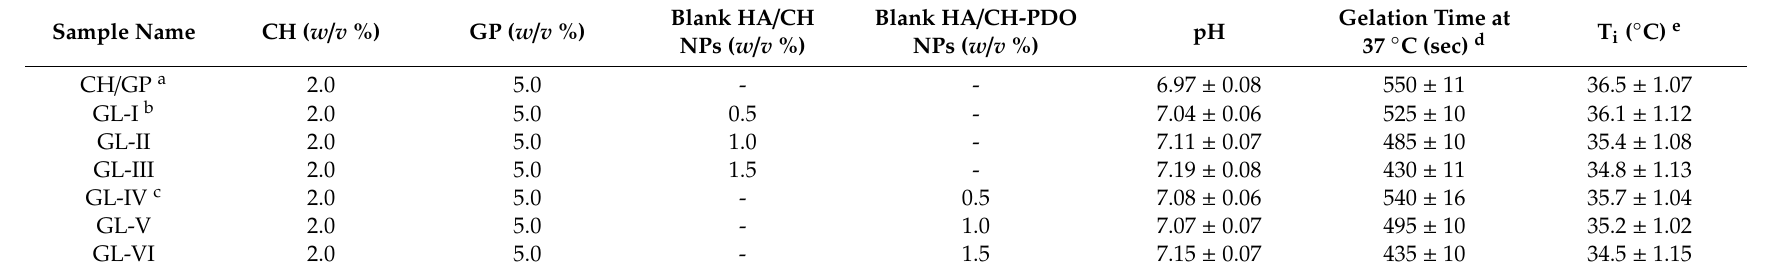
Table 3. Parameters for hydrogels without BMP-2